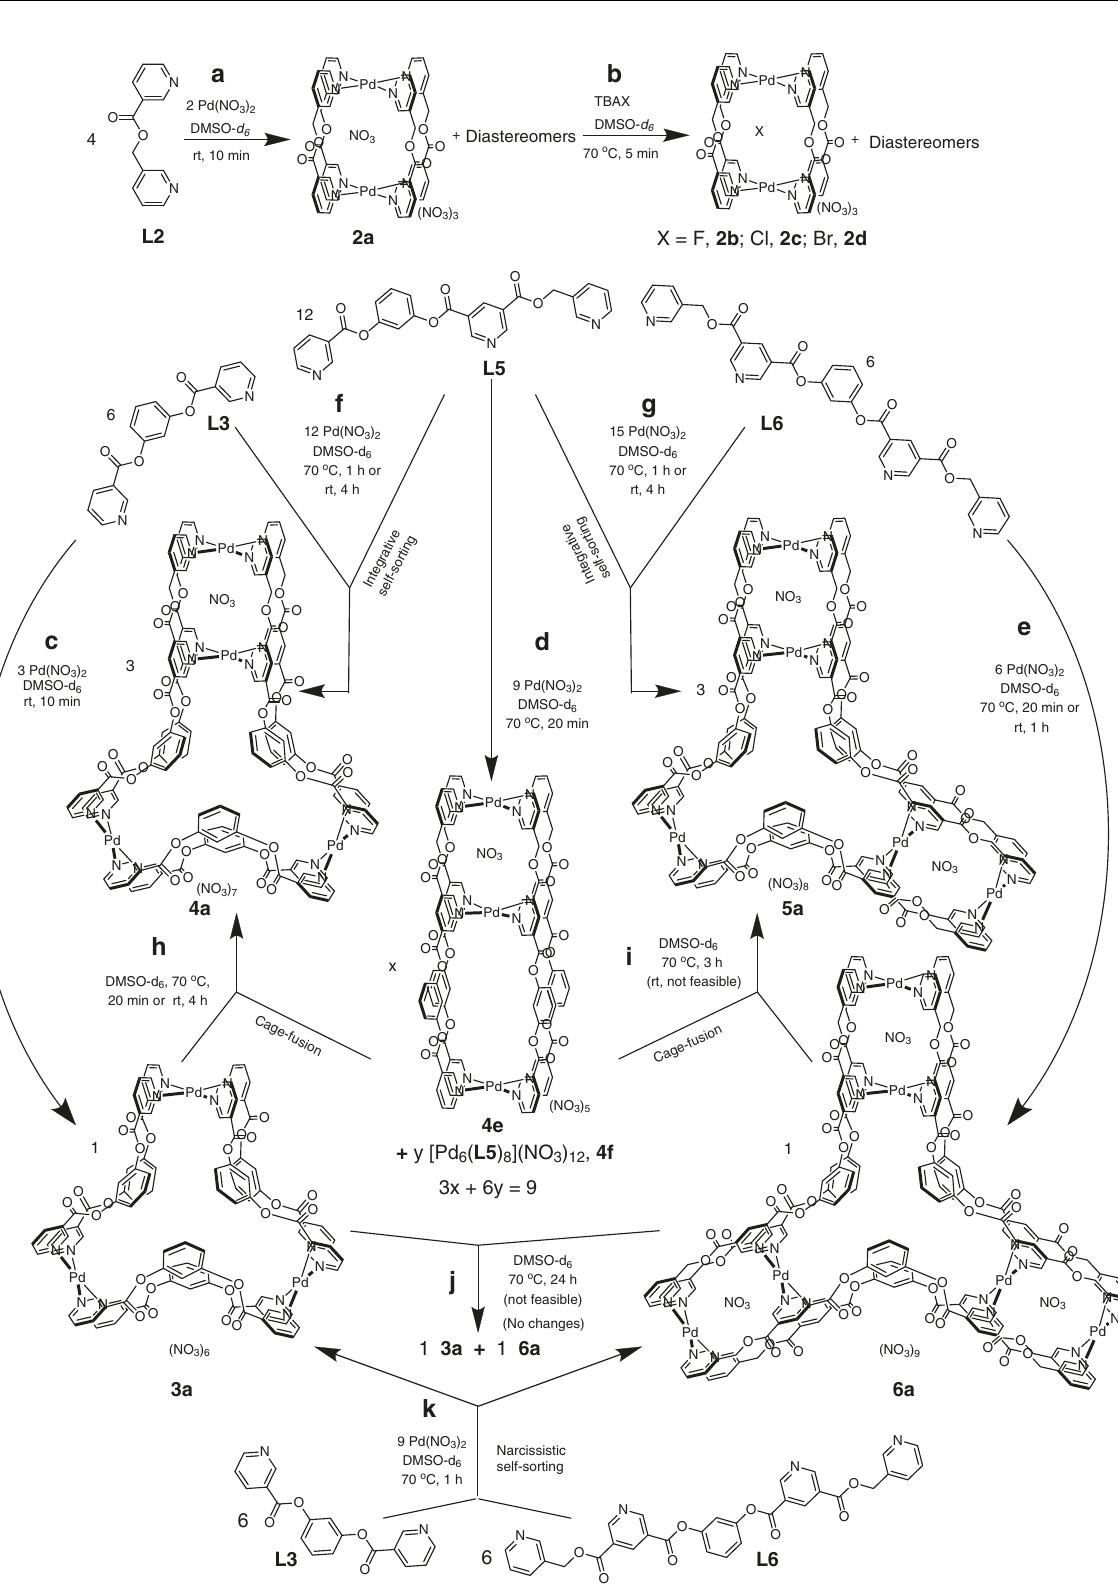
Fig. 3 Synthetic scheme for the complexes 2a − 2d, 3a − 6a, and 4e/4f. Self-assembled coordination cages featuring one or more 3D-cavity constructed by complexation of Pd(NO 3 ) 2 with appropriate ligand(s) to afford a/b/c/d/e homoleptic complexes; f/g heteroleptic complexes via integrative self-sorting; k mixture of homoleptic complexes via narcissistic self-sorting. Cage-fusion reactions to yield h/i heteroleptic complexes (however, no fusion in the case of j